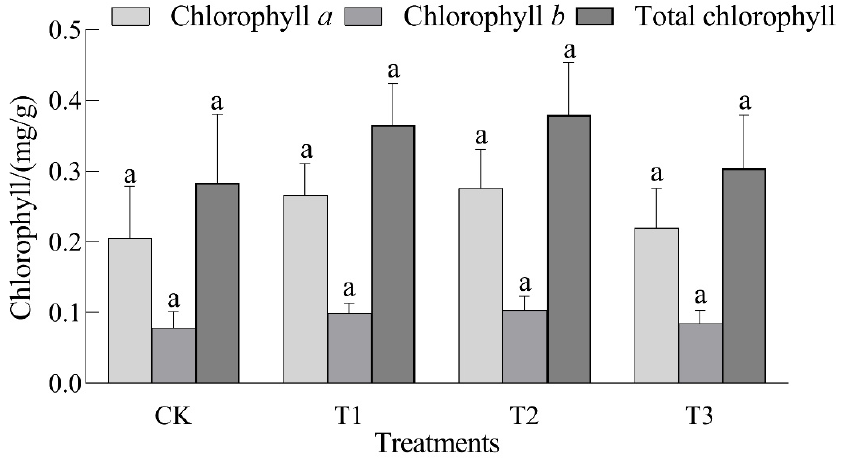
Figure 5. Effects of different treatments on chlorophyll in tobacco leaves. Note: Different lowercase letters indicate that the differences between treatments reached a signifi- cant level (P<0.05).